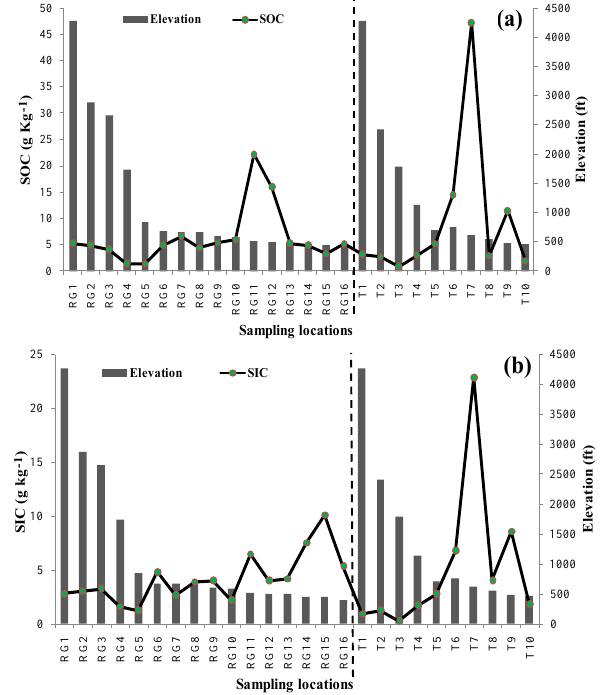
Figure 6. Spatial variation in the SOC and SIC concentration of the Ramganga River and its